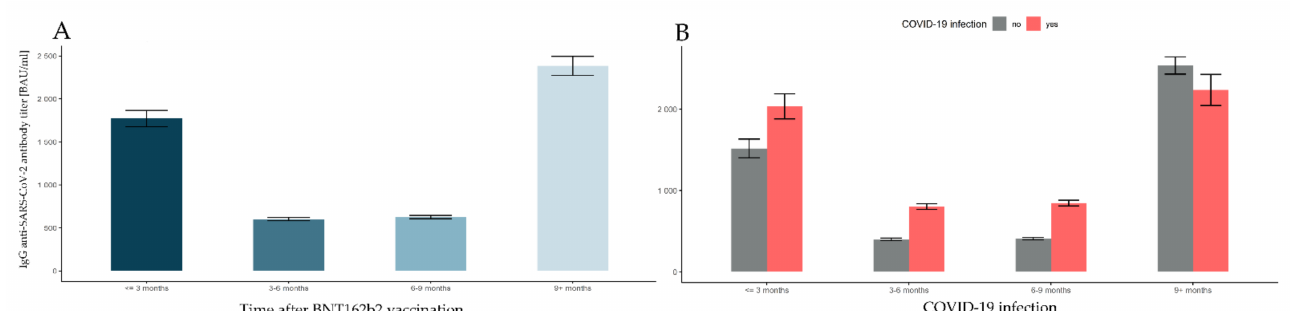
Figure 2. Comparisons of antibody levels following full vaccination with BNT162b2, taking into account the time factor and the incidence of SARS-CoV-2 infection. The error bars for marginal means with 95% confidence intervals (bootstrapped) are presented in turn: ( A ) the time elapsed after the full BNT162b2 vaccination; ( B ) the prior COVID-19 infection grouped with different time intervals elapsed after full BNT162b2